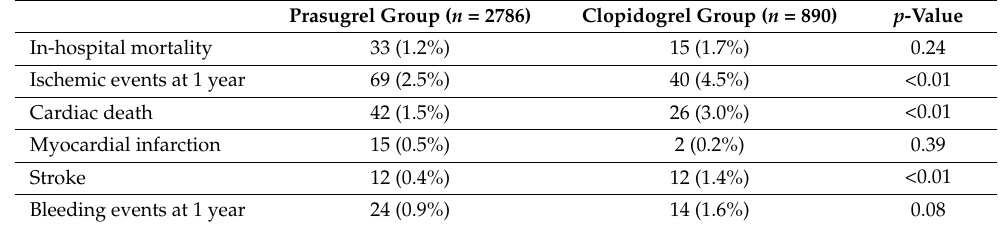
Table 3. Clinical outcomes.